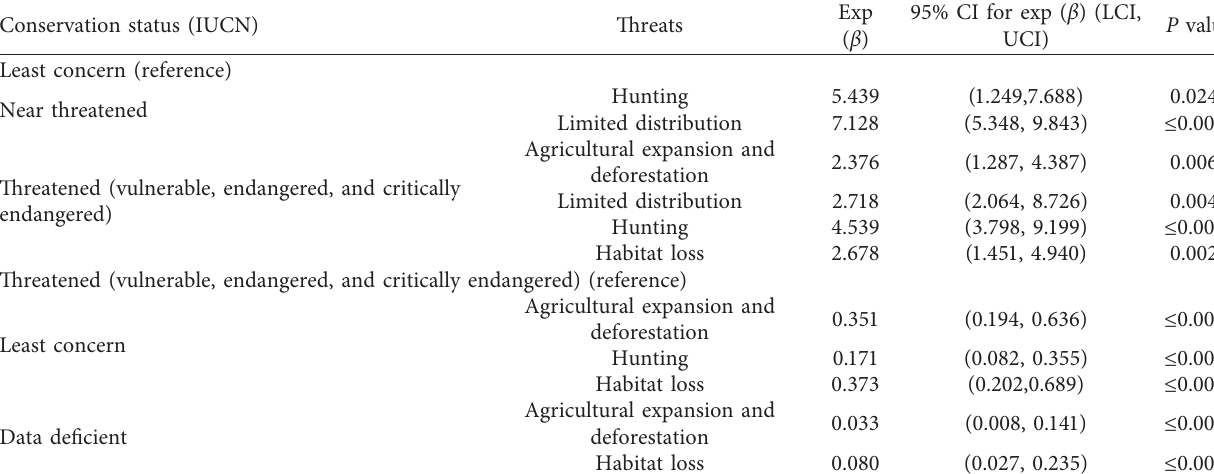
Table 2: Multinomial logistic model shows determinant factors of the conservation status of endemic mammals from the EA, comparing all collectively threatened species, and near threatened species with the least concern species, and then comparing least concern and data deficient species with all threatened species to forecast future threats for unthreatened